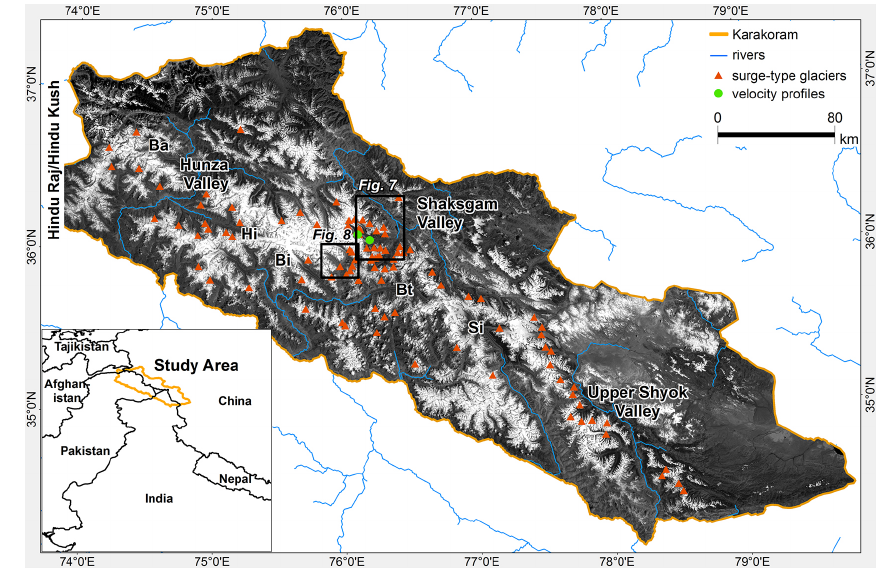
Figure 1. Overview map of the Karakoram. Surge-type glaciers are marked with red triangles. The locations of major glaciers and groups are indicated. Abbreviations: Ba – Batura Glacier, Bi – Biafo Glacier, Bt – Baltoro Glacier, Hi – Hispar Glacier, and Si – Siachen Glacier. Green dots represent the Skamri and South Skamri glaciers, for which velocity profiles are shown in the results section. Locations of Figs. 7 and 8 are outlined. Background: Landsat mosaic over 2011 ( © USGS,